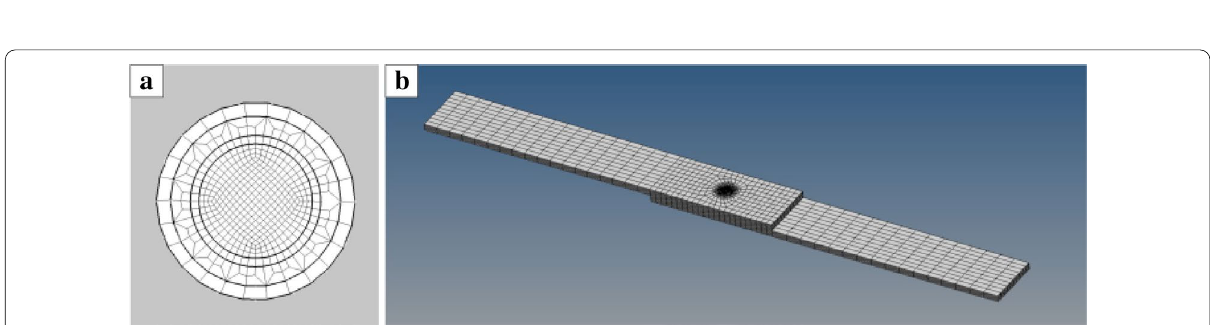
Figure 9 Meshing result of the welded specimen: a Grid within the weld; b Overall